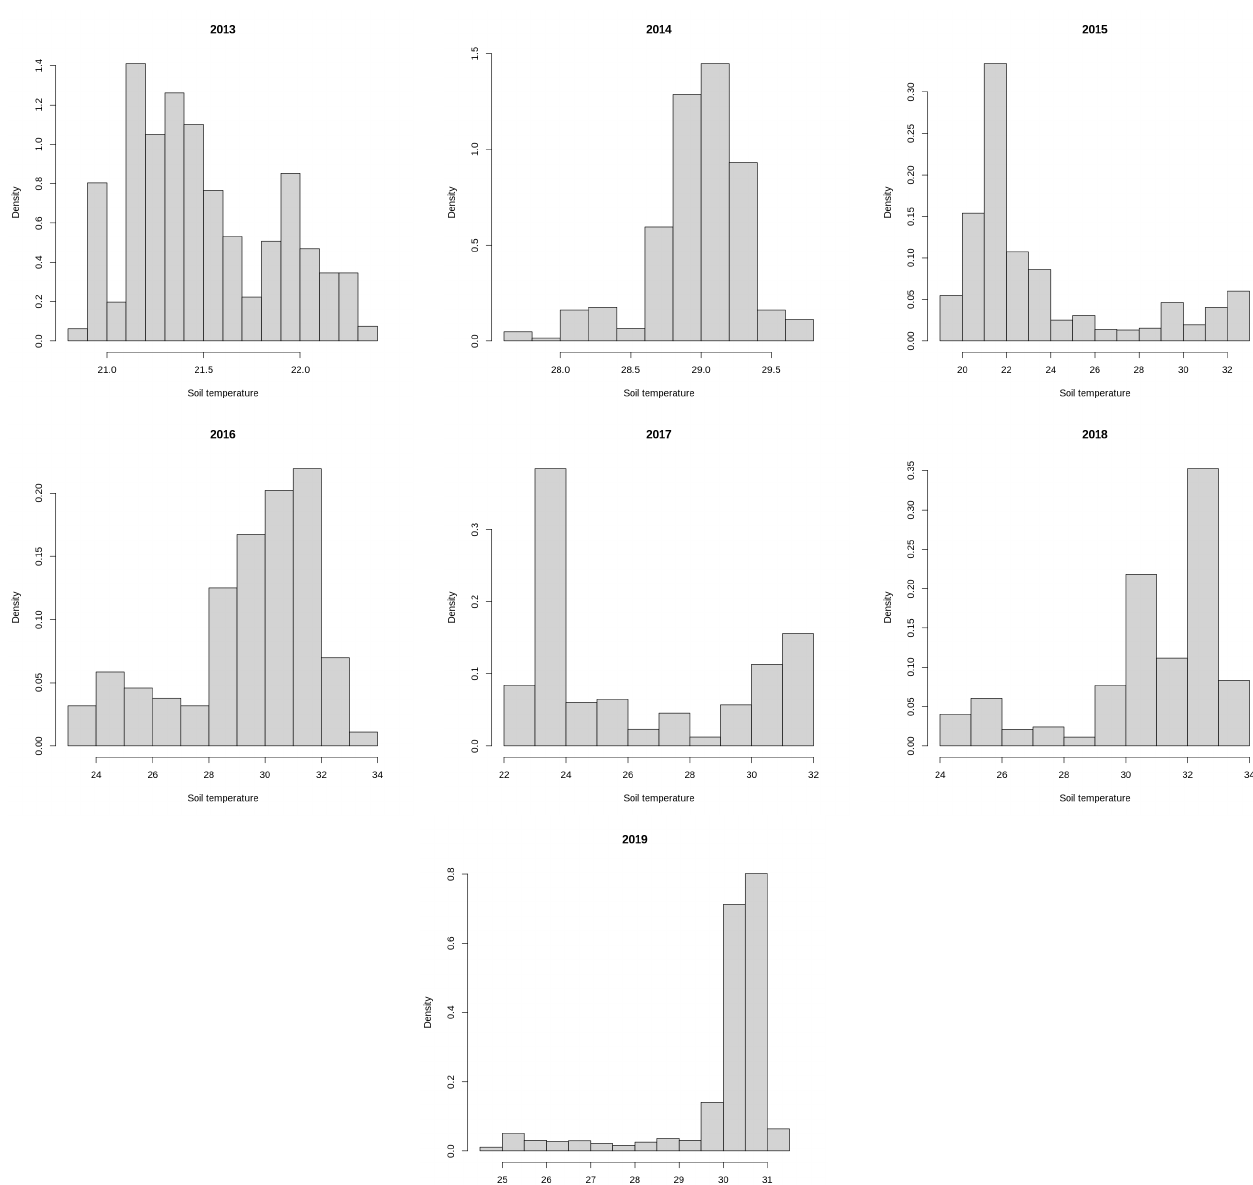
Figure A2. Distribution of soil moisture measurements at 30 cm, the arable land monolith, the lysimeter station for 2013–2019, Poluyamki, Altai Krai, Russia. Available data from August to September in 2013; June of 2014; from May to September in 2015 and 2016; from May to August in 2017, 2018 and 2019. Calculated by the authors based on hourly data from LYS.